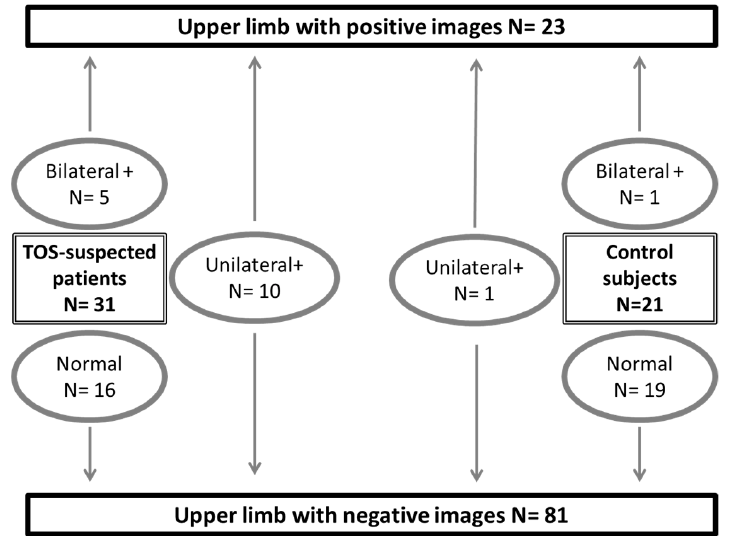
Figure 2. Distribution of studied subjects and results from ultrasound (+/- angiography in patients with suspected thoracic outlet syndrome: TOS) imaging. A positive result (+) is the presence of arterial compression on either ultrasound or angiography. “N” is number of observations.